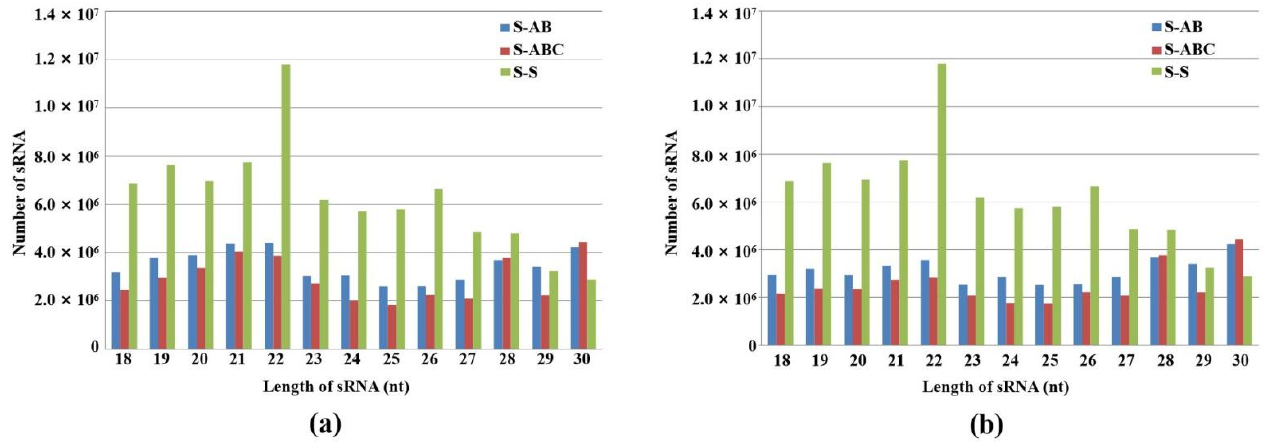
Figure 1. Size distribution and abundance of sRNAs in FgHV1-infected F. graminearum . ( a ) 18–30 nt total sRNA distribution in S-AB, S-ABC and S-S. ( b ) 18–30 nt total sRNA distribution in S-AB, S-ABC and S-S after filtering out FgGMTV1-derived sRNA. The y -axis indicates the reads number of sRNAs, and the x -axis represents the length distribution. S-S (virus-free strain), S-AB (S-S strain infected with DNA-A and DNA-B segments of FgGMTV1), S-ABC (S-S strain infected with DNA-A, DNA-B and DNA-C segments of FgGMTV1).